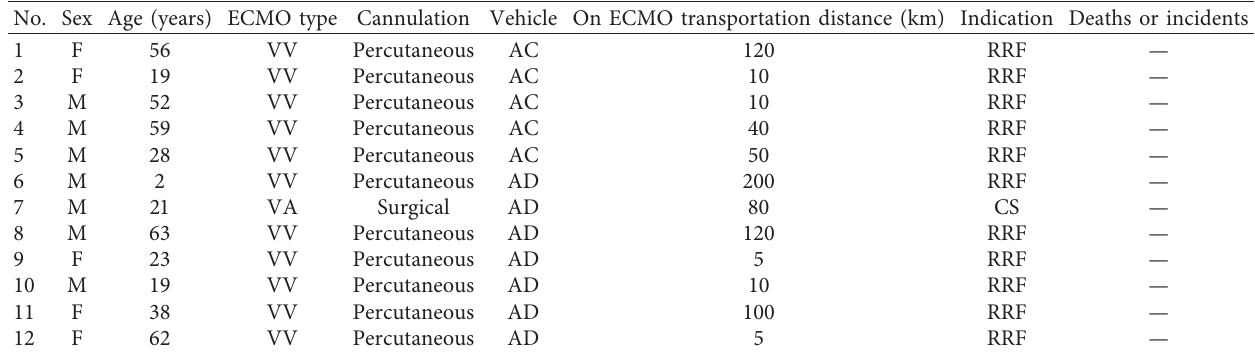
Table 1: Summary of our experience with transfers of the ECMO-supported patients.